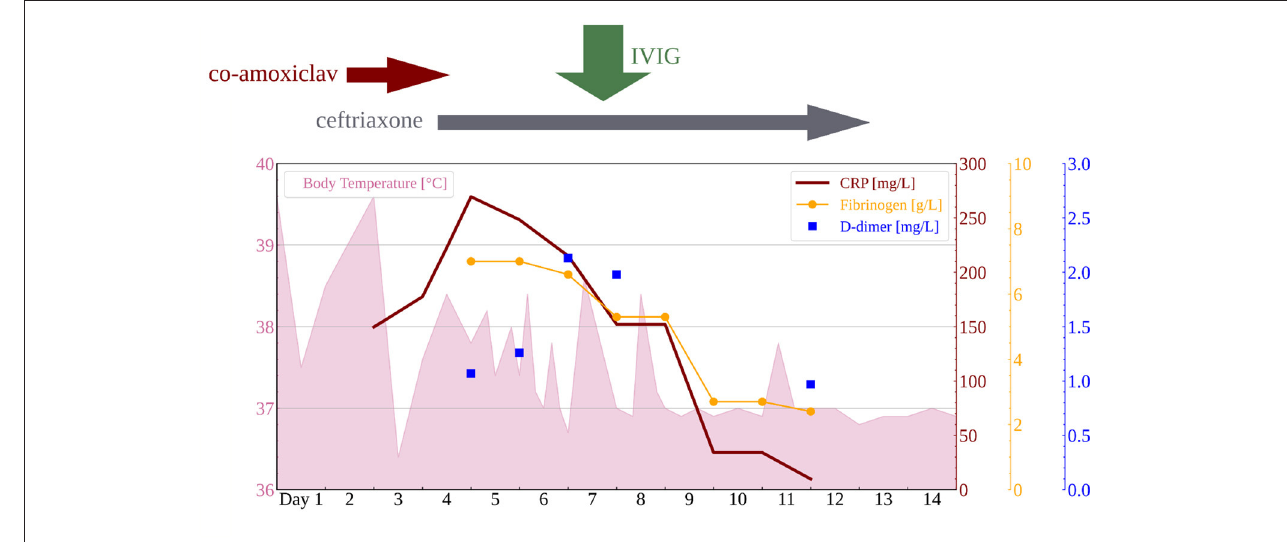
FIGURE 1 | Body temperature and laboratory